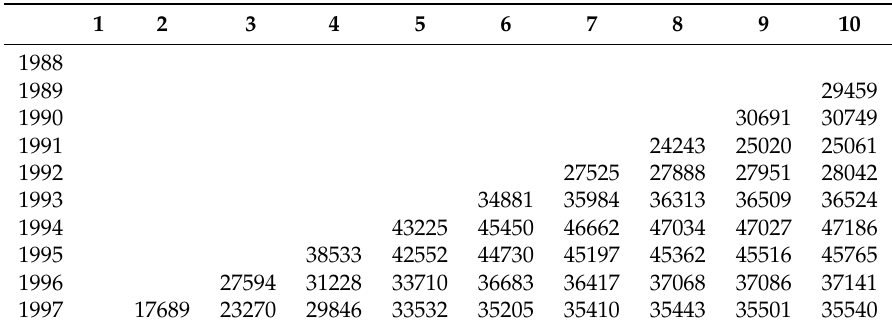
Table 3. Cumulative paid loss triangle observed in the future (commercial auto data set, group code